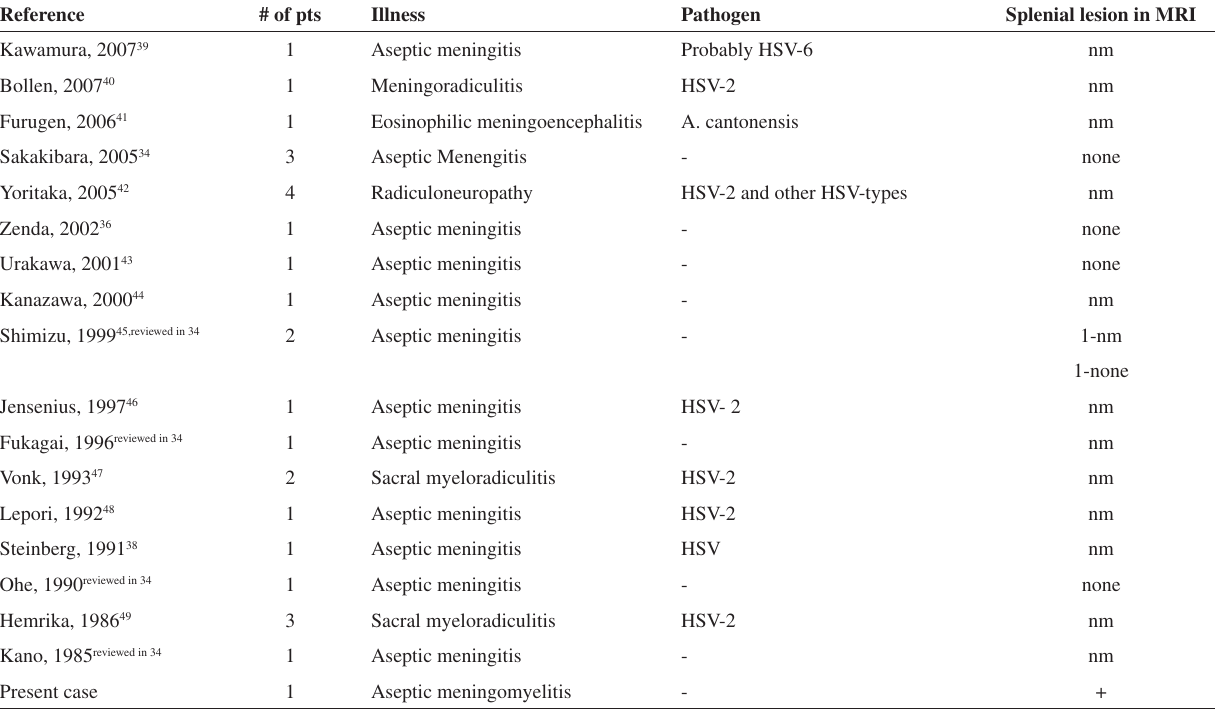
Table 2 - Cranial MRI findings in patients with neurogenic bladder due to meningitis-retention syndrome Reference # of